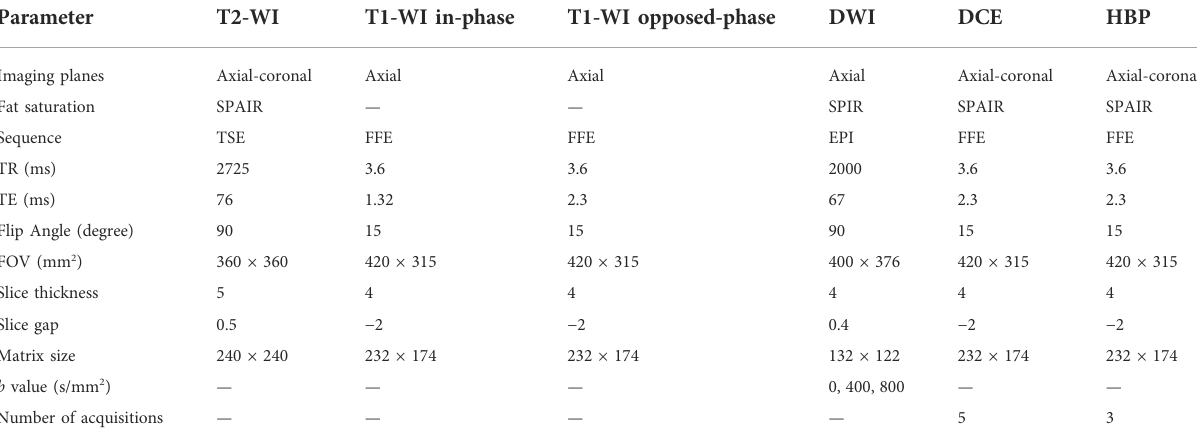
TABLE 1 Technical details of MRI scanning parameters. The DWI sequences involved the ADC map calculation. T2-WI, T2-weighted images; DWI, diffusion-weighted images; HBP, hepatobiliary phase; T1-WI, T1-weighted images; DCE, dynamic contrast enhancement; SPIR, spectral presaturation with inversion recovery; TSE, turbo spin echo; SPAIR, spectral attenuated inversion recovery; FFE, fast fi eld echo; EPI, echo planar imaging; TE, time to echo; TR, time to repetition; FOV, fi eld of